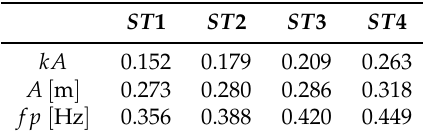
Table 2. Measured parameters at focus [32].